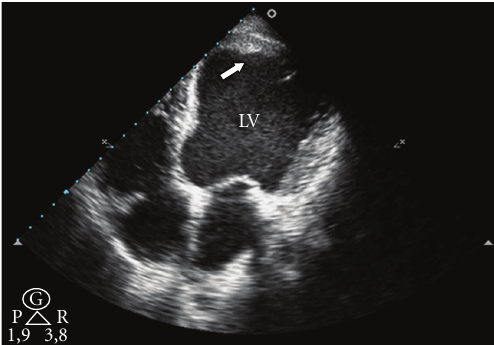
Figure 2: Transthoracic echocardiogram image showing thrombus sessile (white arrow) on left ventricular apex (LV).